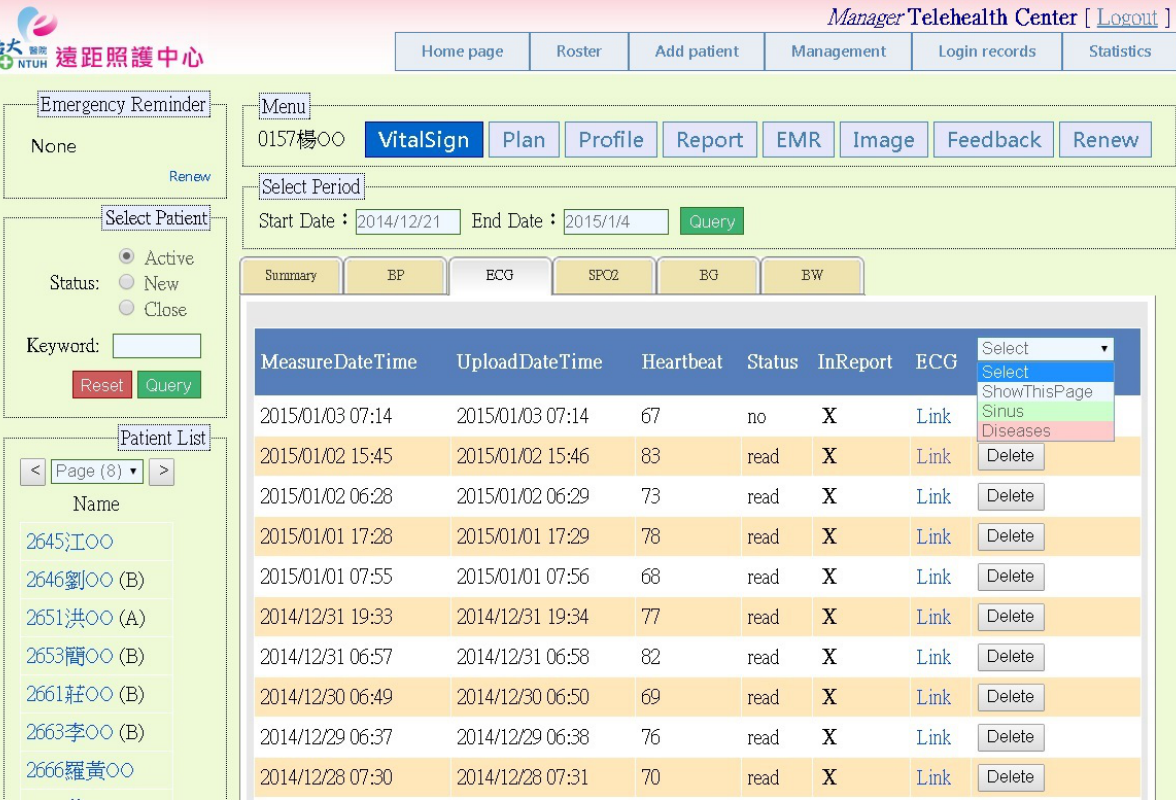
Figure 4. A screenshot of the telesurveillance system. Users are able to access the required information on the platform, such as patients’ biometric data, electronic medical records, and monthly statistical